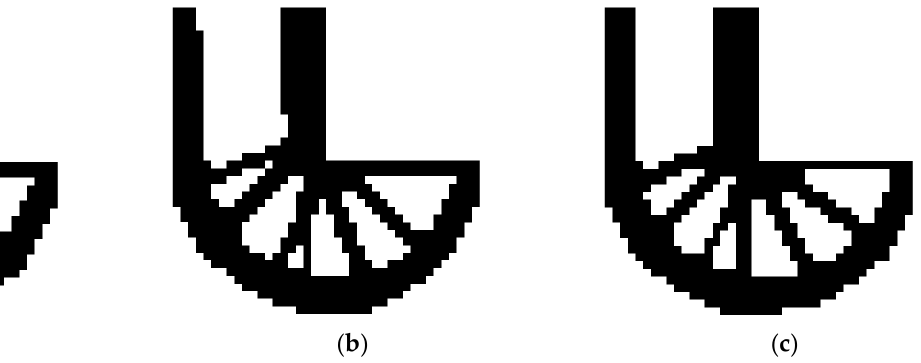
Figure 7. Topological configurations obtained by the two algorithms. ( a ) 𝐶 = 37.6460 ， 𝑡 = 31 . ( b ) 𝐶 = 37.6116 ， 𝑡 = 33 . ( c ) 𝐶 = 37.7607 ， 𝑡 = 41 . Table 2. The SA-BESO algorithm for the loaded knee structure — the optimization result data when deletion rate being 2.5%.